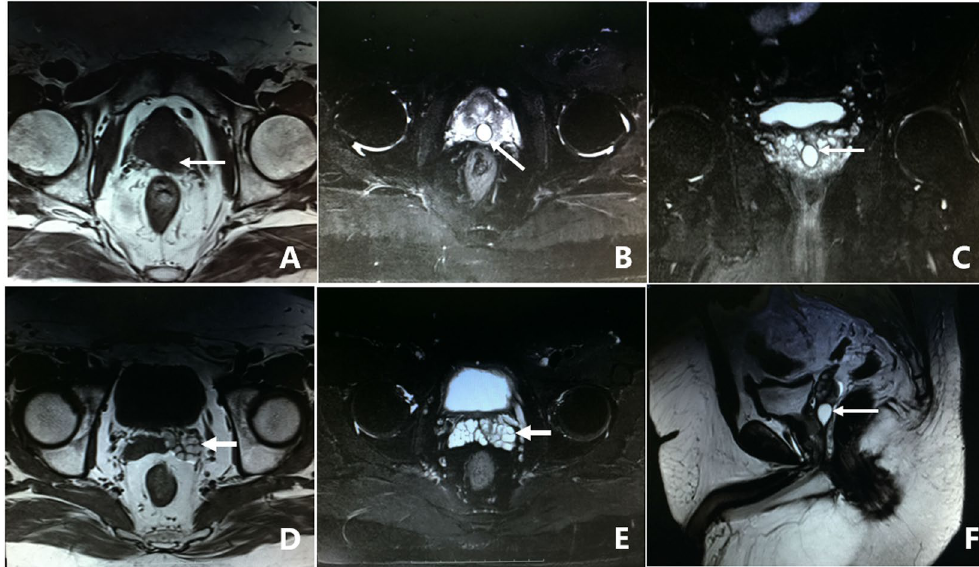
Figure 3. MRI image of PUC. ( A ) There is a 1.0 × 1.2 cm low-intensity signal cyst in the midline of the prostate on T1WI. ( B , C , F ) The cyst presents as high-intensity signal on T2WI. ( D , E ) The left SV presents as high signal intensity on both T1WI and T2WI, and its width has expanded to 2.1 cm. This pattern suggests that the cyst is a PUC and is accompanied by enlargement and an old hemorrhage in the left SV.